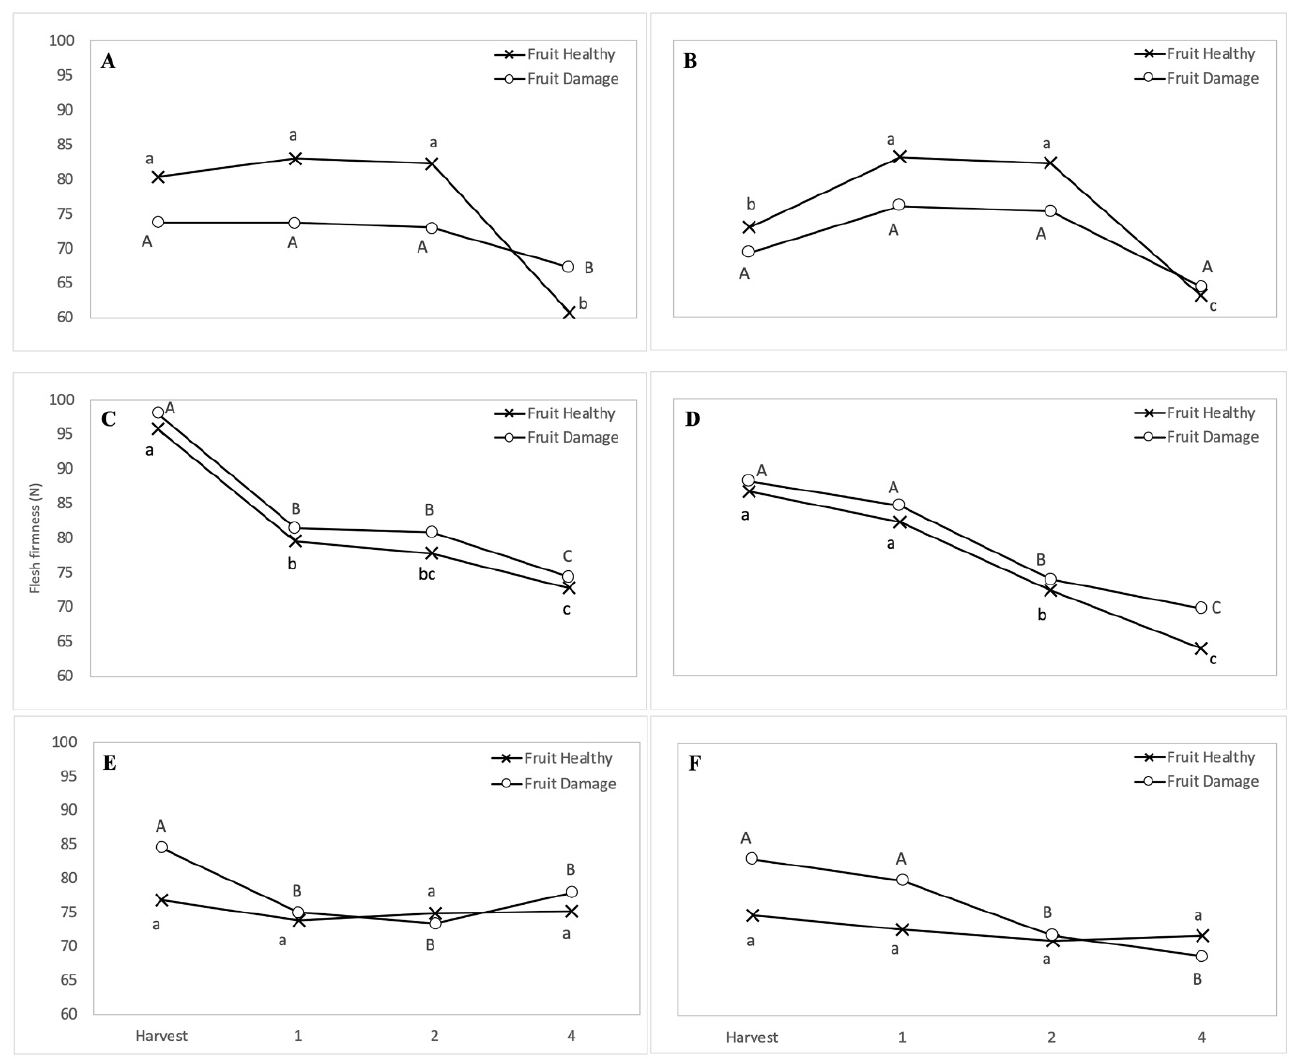
Fig. 6: Evolution of flesh firmness (newton) in apple from cv. Brookfield® (A and B), Granny Smith (C and D) and Fuji (E and F), from harvest to 4 months of cold storage from conventional (A, C and E) and organic (B, D and F) orchard, in healthy and sun-burned